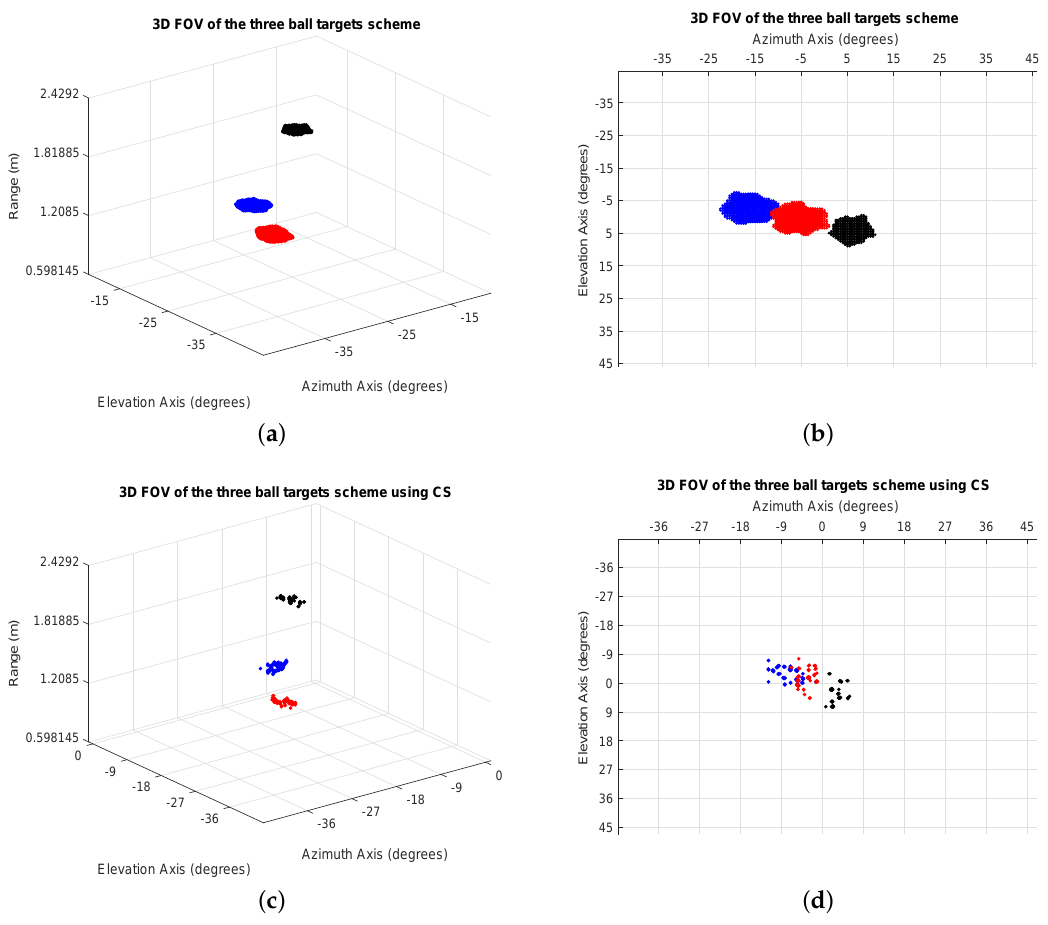
Figure 8. Experiment results. ( a , b ) IRT method; ( c , d ) CS applying Equation (38) to the slow-time